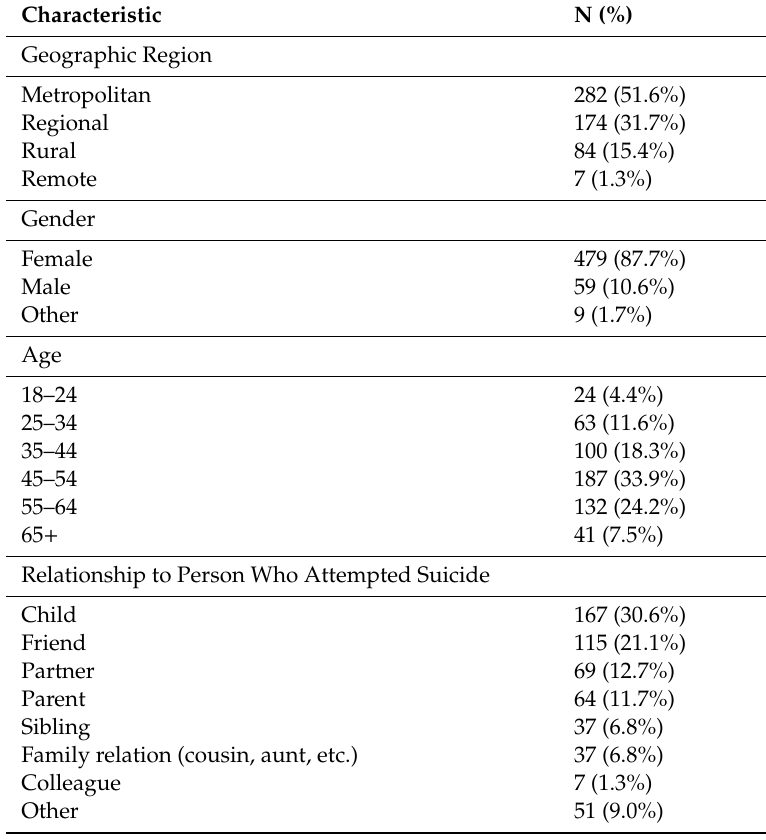
Table 1. Demographic information of participants (N = 547